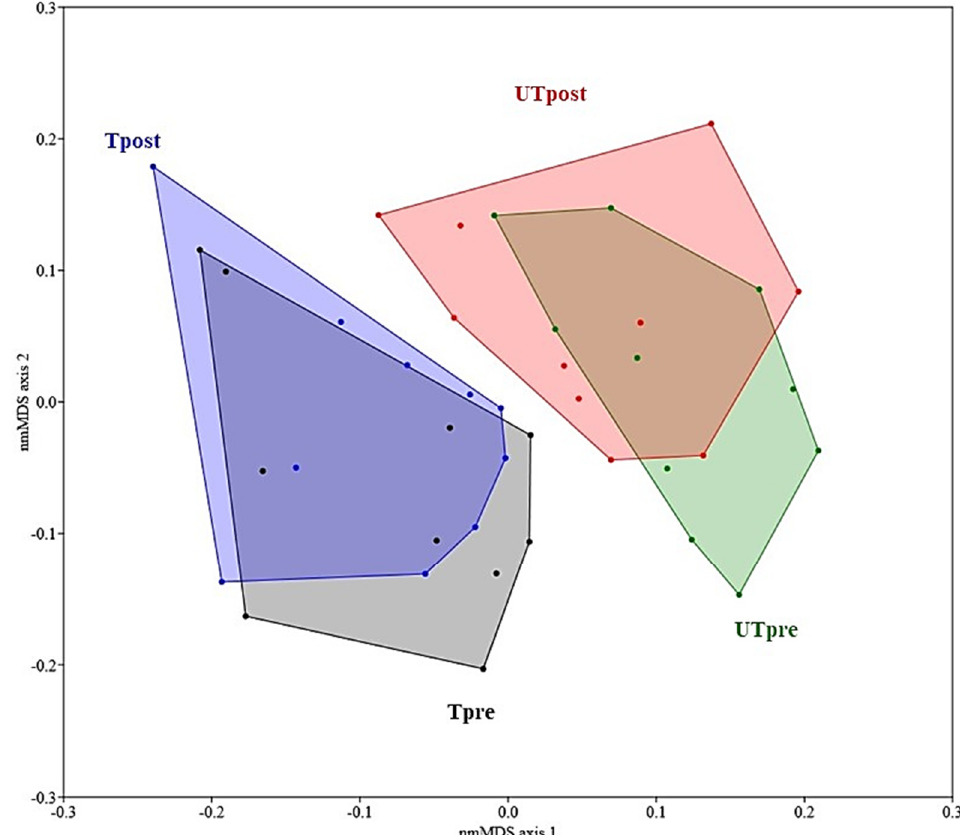
Figure 2. A nmMDS representation of physical parameters ( n = 39) measured in X-Adapt project (UTpre (green)—untrained pre-exercise testing, UT-post (red)—untrained postexercise testing, Tpre (black)—trained pre-exercise testing, Tpost (blue)—trained postexercise testing). Stress value of nmMDS was 0.185. Please also see Figure S2 for more details.